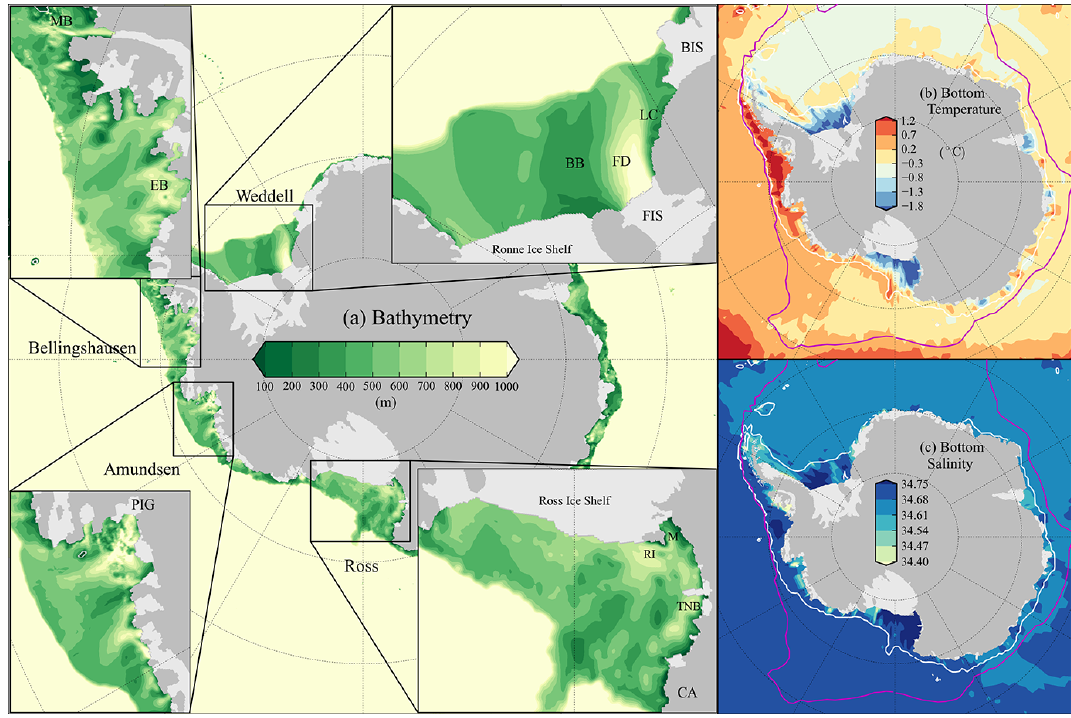
Fig. 1. (a) Bathymetry, (b) bottom temperature and (c) salinity of the Southern Ocean. Bathymetry and land mask are taken from the RTOPO data set (Timmermann et al., 2010). Ocean data are taken from the World Ocean Atlas (2009) temperature (Antonov et al., 2010) and salinity (Locarnini et al., 2010) data sets. The white line in (b) and (c) is the 1000m isobath contour. The southern boundary of Upper Circumpolar Deep Water (magenta line) taken from Orsi et al. (1995) is used to define the southern boundary of the Antarctic Circumpolar Current in panels (b) and (c) . BB: Berkner Bank, FD: Filchner Depression, FIS: Filchner Ice Shelf, BIS: Brunt Ice Shelf, LC: Luitpold Coast, MB: Marguerite Bay, EB: Eltanin Bay, PIG: Pine Island Glacier, RI: Ross Island, MS: McMurdo Sound, TNB: Terra Nova Bay, CA: Cape